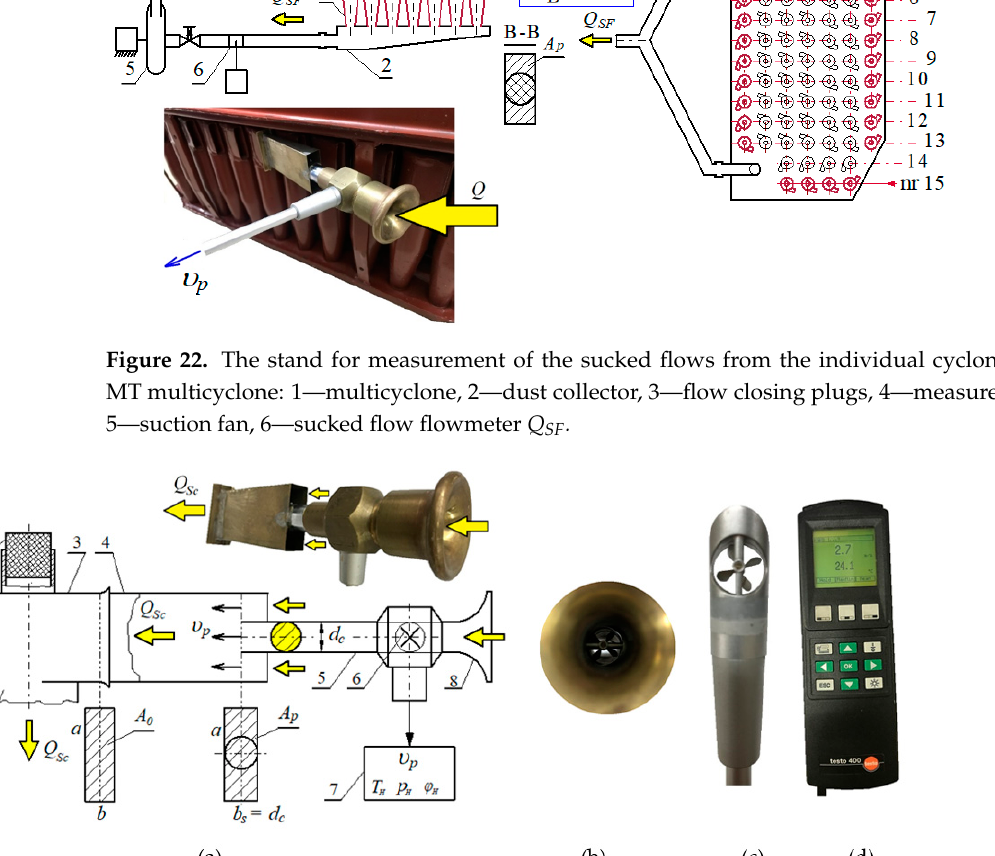
Figure 22. The stand for measurement of the sucked flows from the individual cyclones of the MT multicyclone: 1—multicyclone, 2—dust collector, 3—flow closing plugs, 4—measurement kit, 5— suction fan, 6—sucked flow flowmeter Q SF .